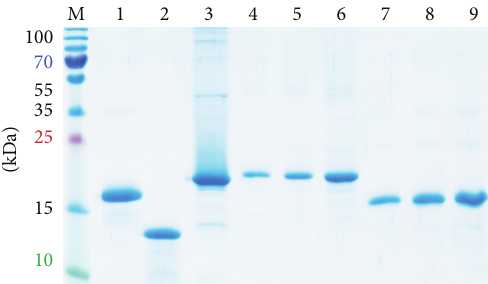
Figure 1: Expression of structural proteins encoded by the 5 󸀠